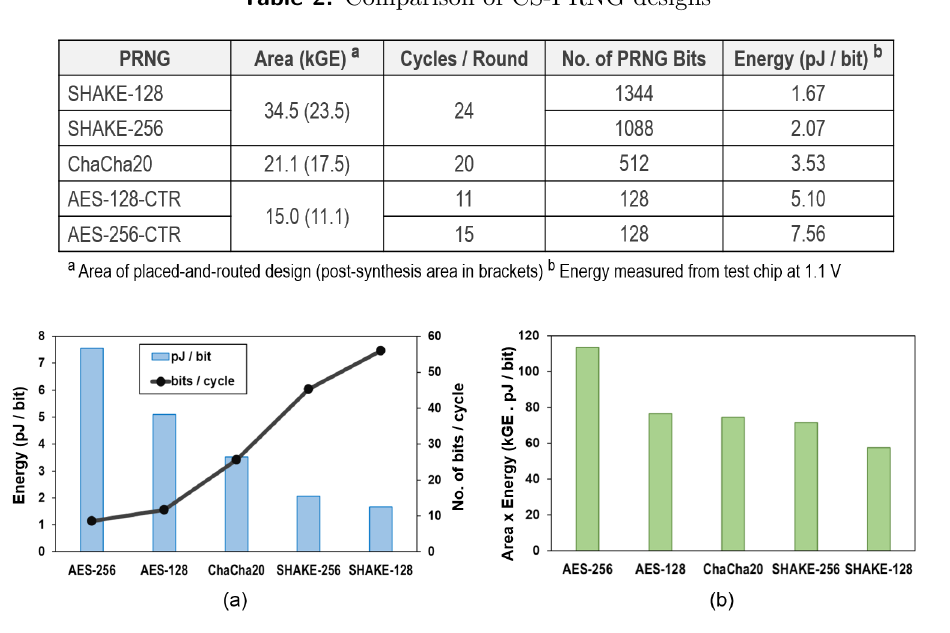
Table 2: Comparison of CS-PRNG designs